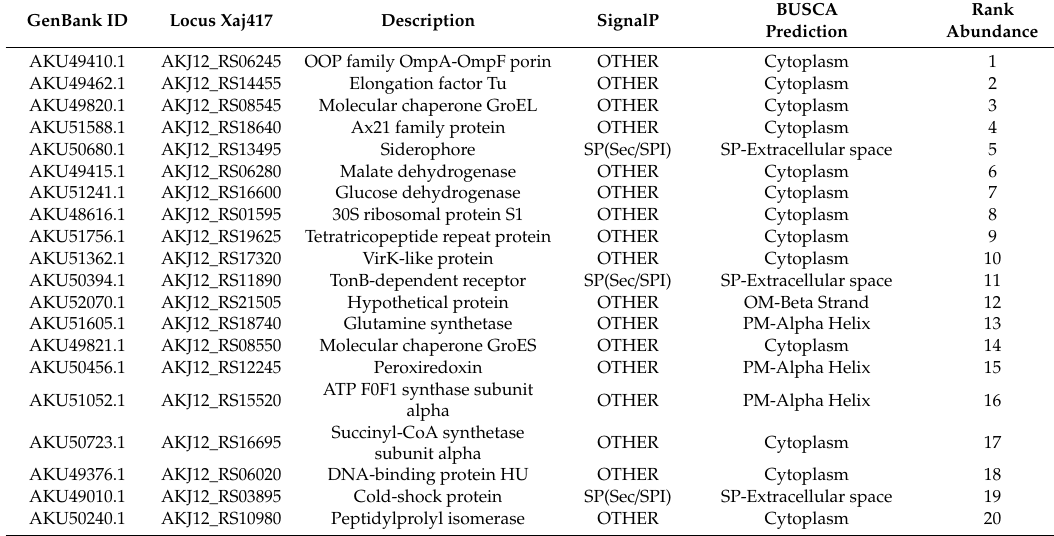
Table 1. Top 20 most abundant Xaj 417 proteins in infected walnut hulls. SP: signal